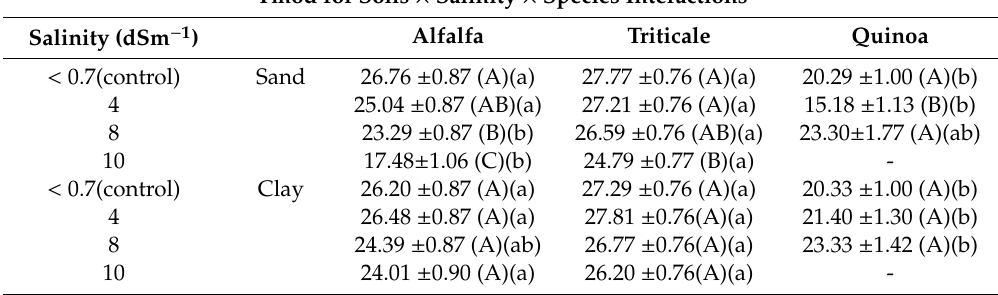
Table 9. Tmod for soils × salinity × species interaction for alfalfa, triticale, and quinoa in two soils types at four di ff erent